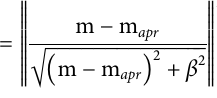
Frontiers in Earth Science |